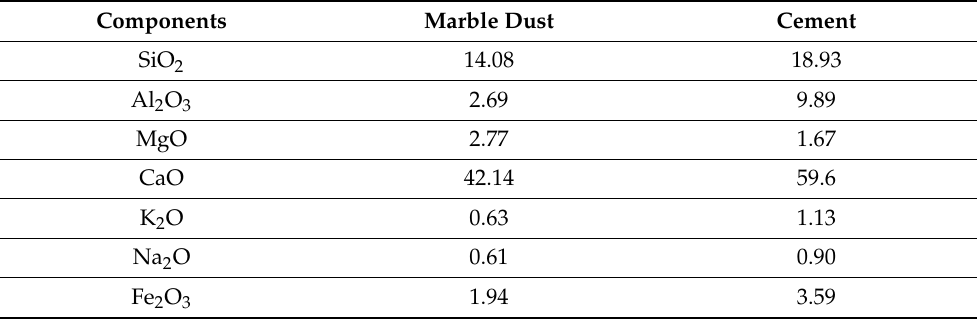
Table 1. Chemical